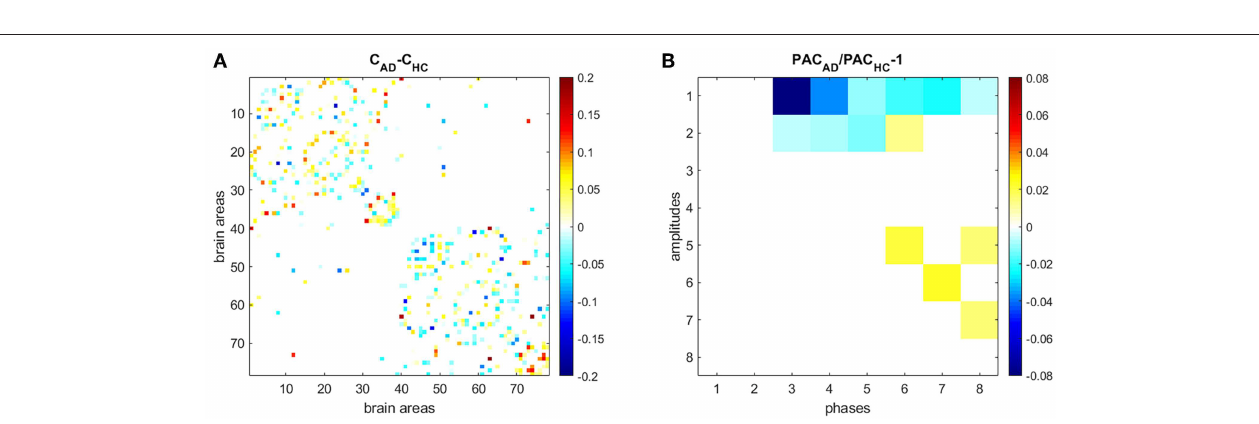
FIGURE 7 | Comparing PAC in HC and AD subjects. (A) Difference between the average connectivity matrix of HC and AD subjects. (B) Comparison between PAC in HC and AD. Non-significant differences ( p < 0.05 ) after correcting by false-discovery rate are displayed in white.